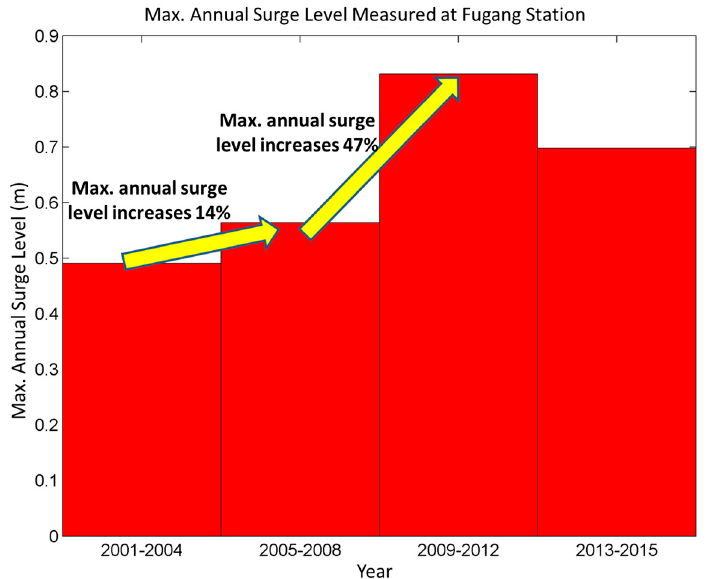
Figure 3. Increasing trend of maximum annual surge level measured at Fugang station located at the southeast coast of Taiwan.